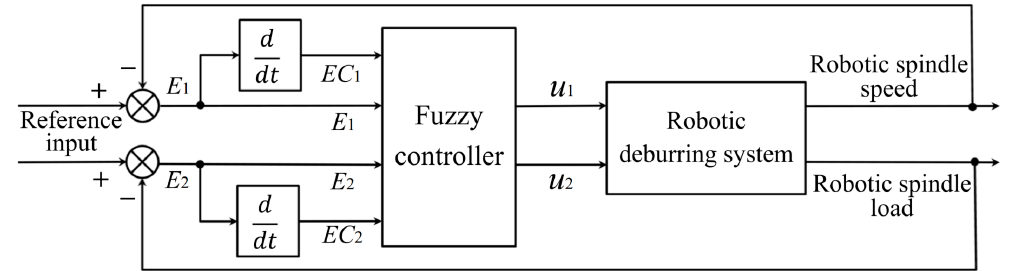
Figure 7. Schematic diagram for deburring process parameter control.